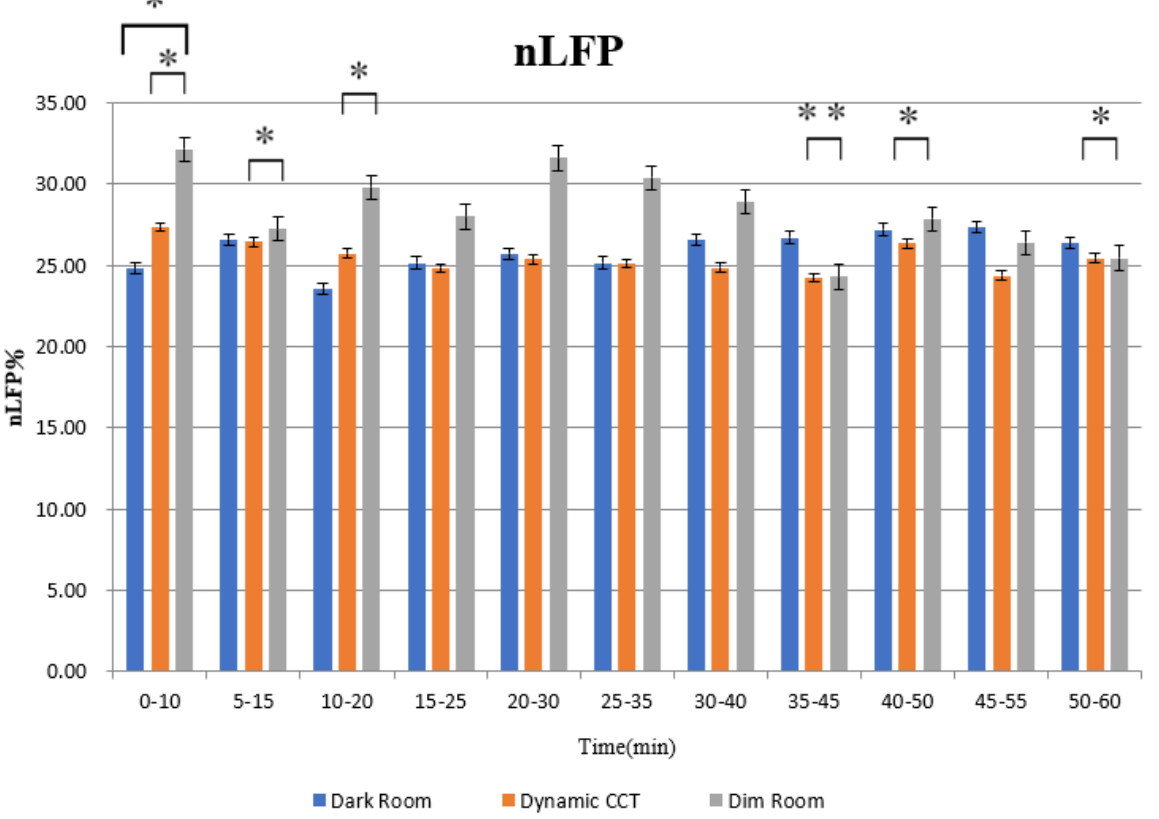
Figure 11. Dark room, Dynamic CCT and Dim light effect comparison chart on nLFP under sleep environment. “*” is p < 0.05, “**” is p < 0.005.